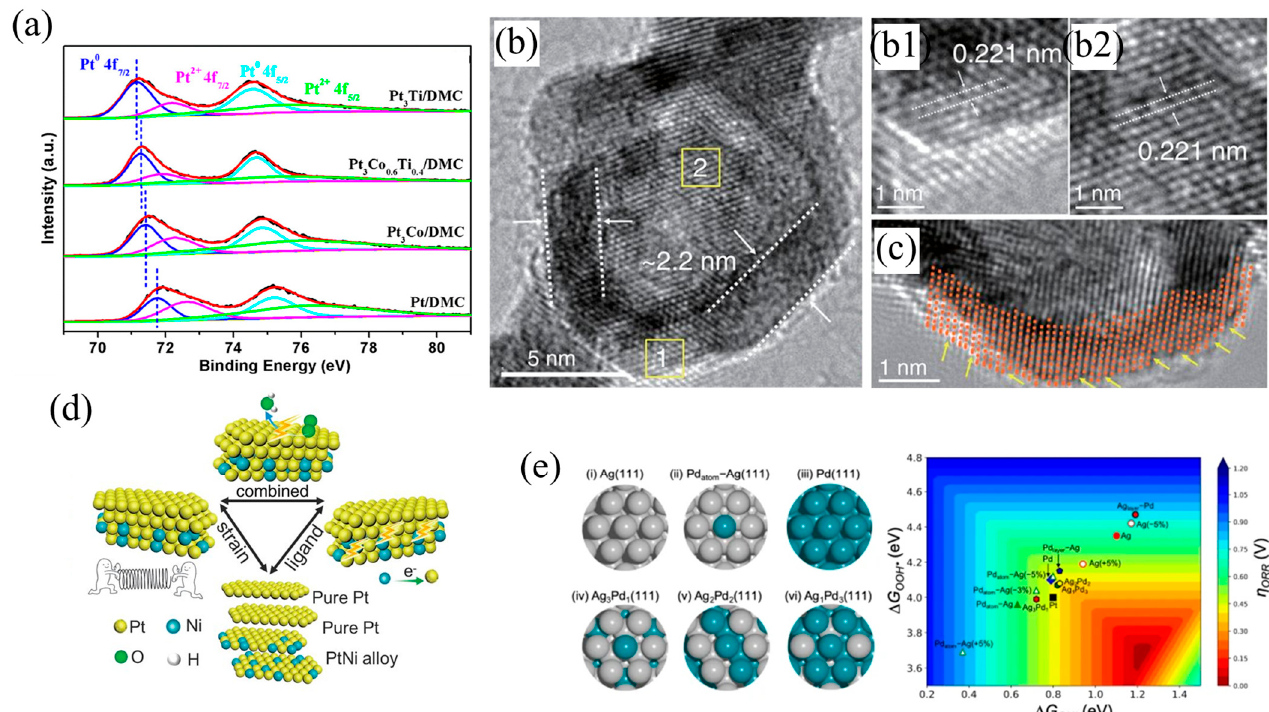
Figure 3. ( a ) Pt 4f XPS spectra of Pt 3 Co 1 − x Ti x and Pt/DMC. Reprinted with permission from Ref. [39]. Copyright 2022, ACS Catalysis. ( b ) Enlarged TEM image and ( b1 , b2 ) the corresponding HRTEM images of the areas marked by yellow squares. ( c ) Atomic-resolution HRTEM image in the edge of Pt–Ni nanocages. ( d ) Illustration of the synergistic effects derived from both the lattice strain and ligand effects in the catalysts. Reprinted with permission from Ref. [19]. Copyright 2019, Nature. ( e ) Ag-Pd active site models investigated by DFT for their effect on ORR activity and oxygen reduction reaction (ORR) activity map showing overpotentials. Reprinted with permission from Ref. [30]. Copyright 2021, Nature